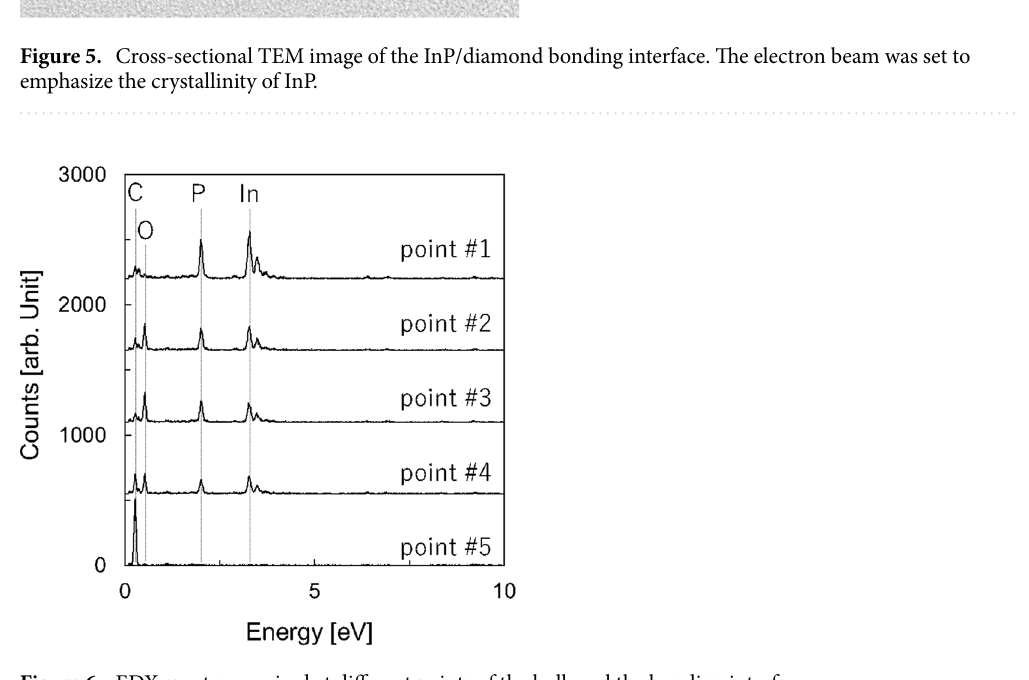
Figure 6. EDX spectra acquired at different points of the bulk and the bonding